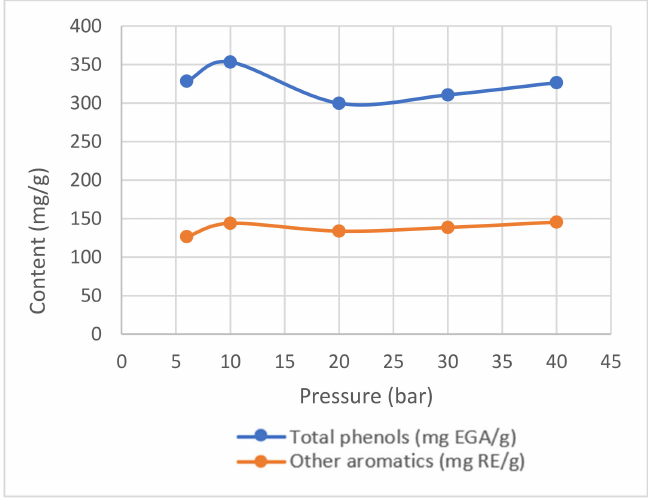
Figure 3. The influence of nitrogen pressure on lignin decomposition in subcritical water.